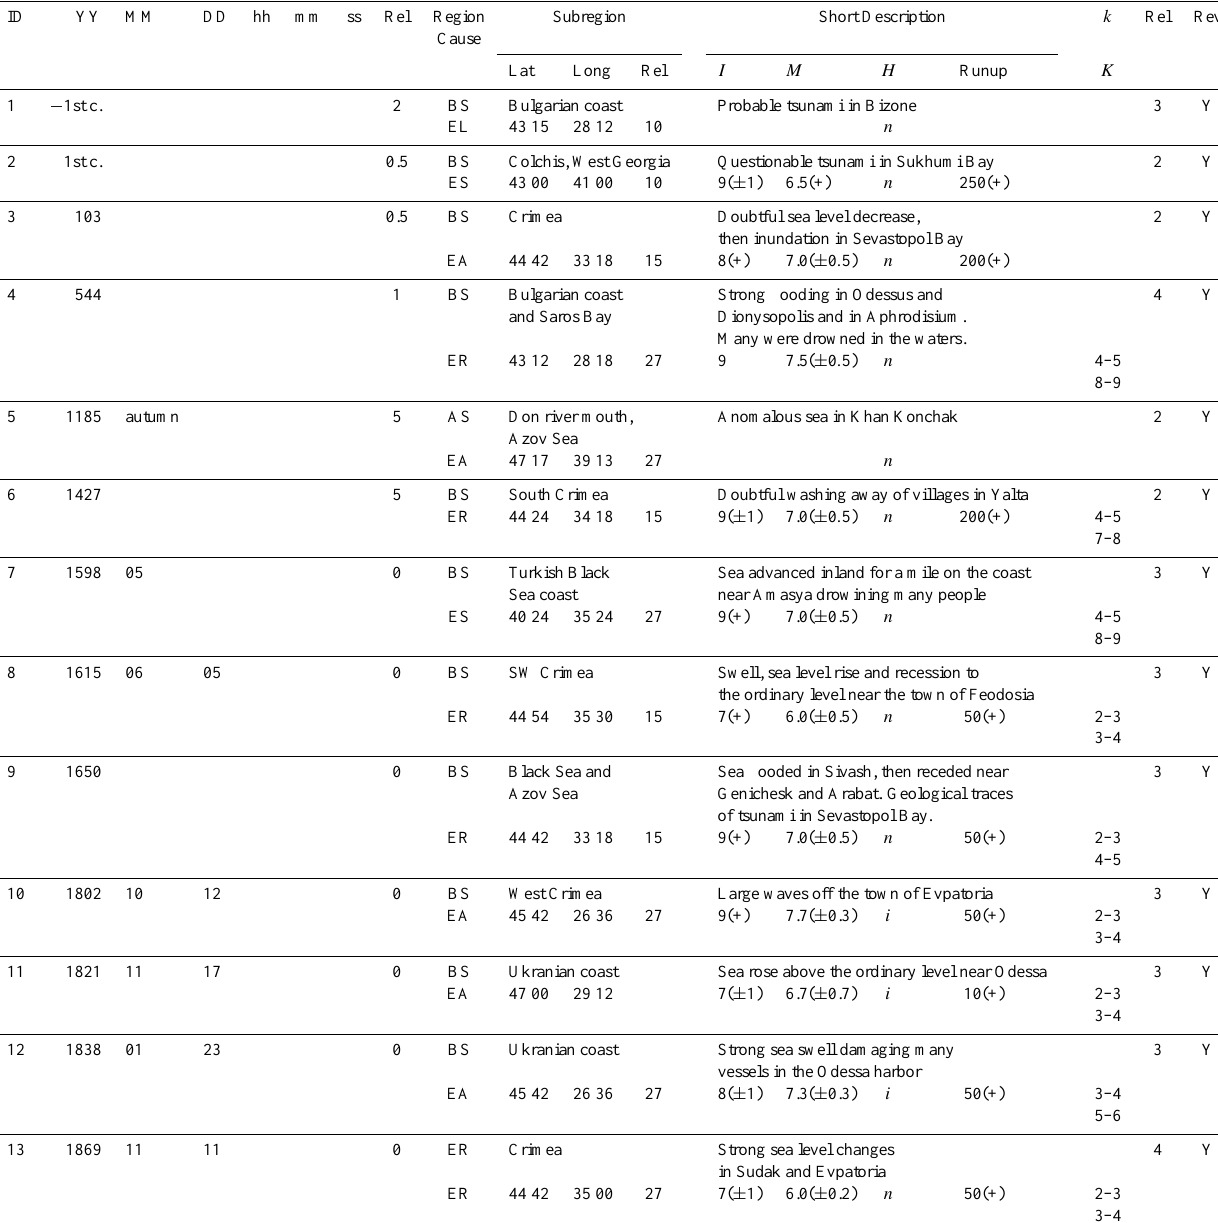
Table 1. Tsunami catalogue for the Black Sea and the Azov Sea. Key: ID=identification number, YY=year, MM=month, DD=day, hh=hour, mm=minute, ss=second, Rel=reliability of the occurrence time, Region BS=Black Sea, AS=Azov Sea, Lat=north latitude, Long=east longitude (both in degrees and minutes), Rel=accuracy of the location in minutes, I =seismic intensity in MM, M =surface-wave magnitude, H =focal depth (in km), n =shallow earthquake, i =intermediate-depth earthquake, Runup=maximum vertical tsunami run-up (in cm), k =tsunami intensity (in Sieberg-Ambraseys 6-grade scale), K =tsunami intensity (in Papadopoulos-Imamura 12-grade scale), Rel=reliability of the tsunami event, Y/N=an indication of whether the tsunami paremeters were revised (Y) or not (N) with respect to previous catalogues. The reliability of the time of occurrence is an expression of the time inaccuracy and is measured in units of the last entry of the time of occurrence (e.g. in years for the event number 3, in months for the event number 7, in days for the event number 8, minutes for the event number 16, etc.). Genesis causes classification: ER=submarine earthquake, EA=earthquake-associated, EL=earthquake landslide, ES=earthquake marine slide, GS=gravitative marine slide. For the reliability of the tsunami events a modified version of the tsunami reliability scale of Iida (1984) was adopted (0=very improbable tsunami; this class practically is not in use since events of class 0 are not inserted in the catalogue; 1=improbable tsunami, 2=questionable tsunami, 3=probable tsunami, 4=definite tsunami). Some additional symbol explanation is needed: (+) after a particular value means “equal to or larger than”; (–) after a particular value means “equal to or less than”; – before the year of occurrence means